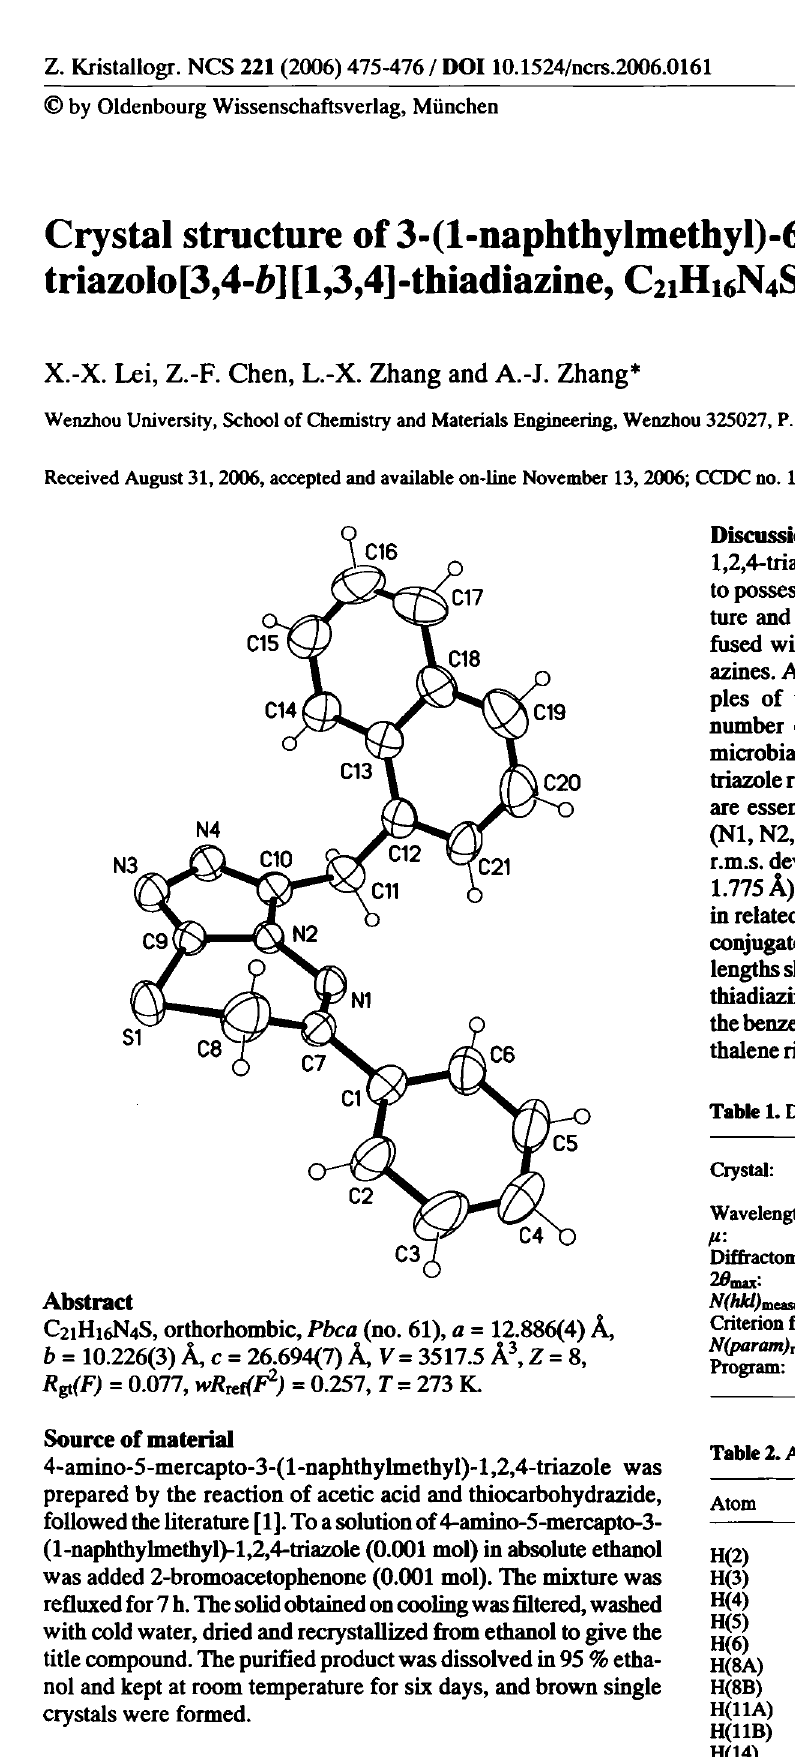
Table 2. Atomic coordinates and displacement parameters (in Ä 2